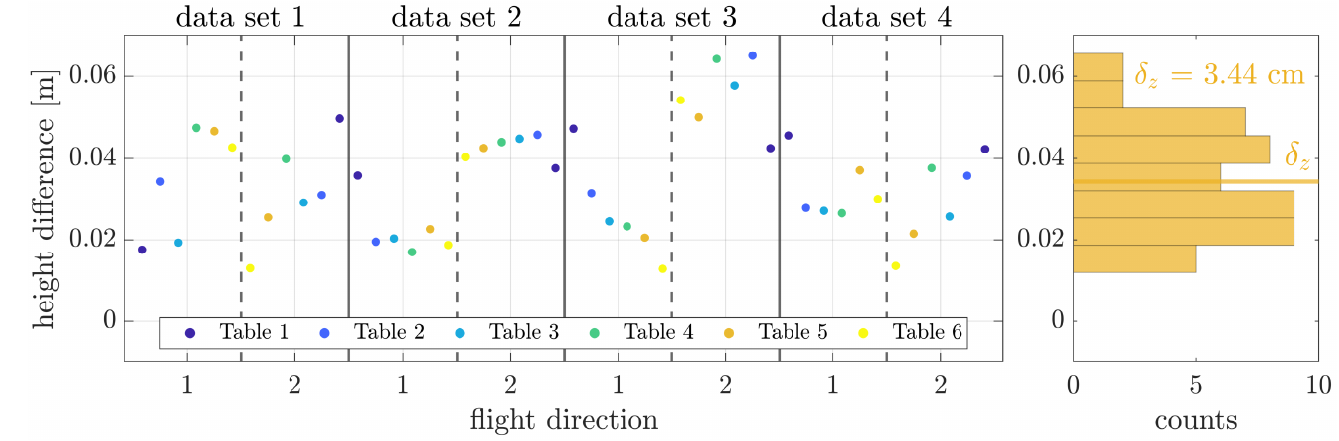
Figure 9. Height difference of estimated table heights for four